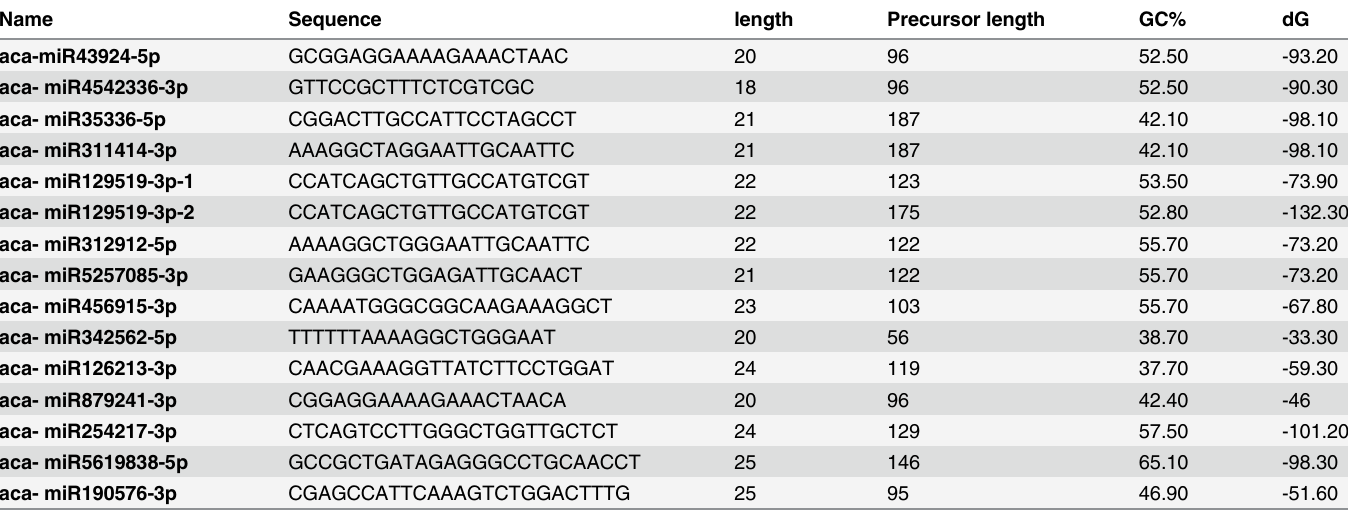
Table 3. Novel miRNAs predicted in A . catenella .